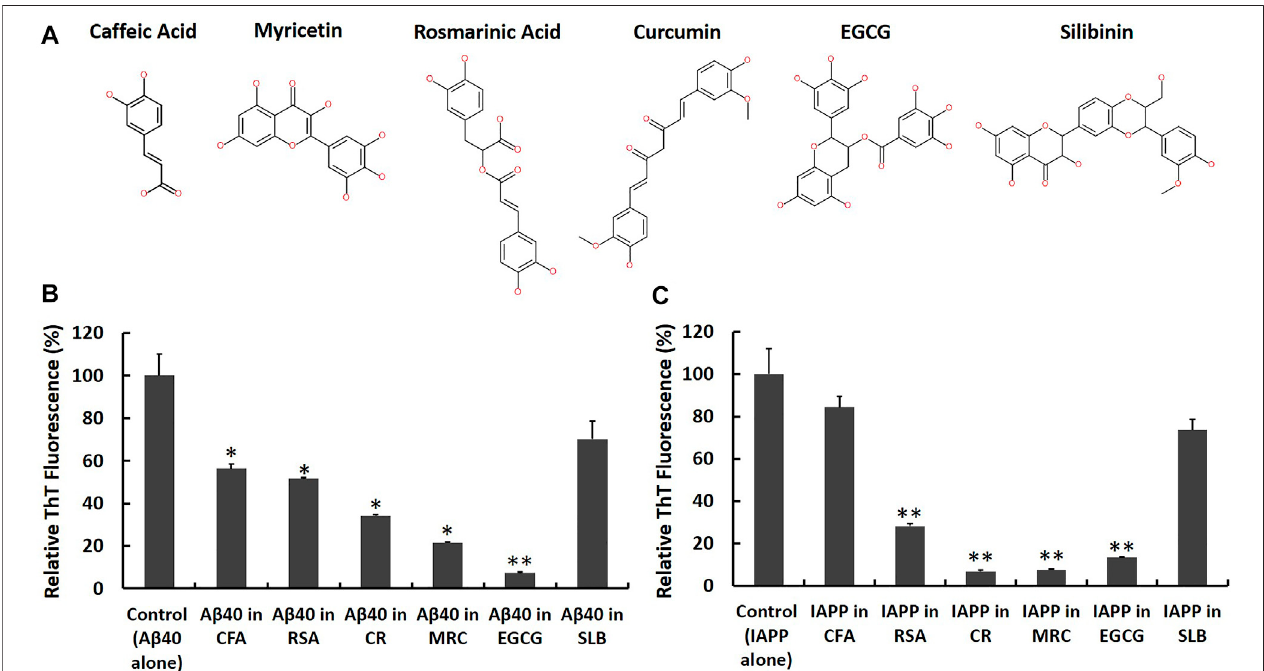
FIGURE 5 | Screening candidate polyphenolic inhibitors against A β 40 and IAPP self-aggregation using ThT fl uorescence assay. (A) 2D chemical structures of the candidate inhibitors including CFA: Caffeic acid, RSA: Rosmarinic acid, CR: Curcumin, MRC: Myricetin, EGCG: (-)-Epigallocatechin gallate and SLB: Silibinin. Samples containing (B) A β 40 monomers (40 μ M) and (C) IAPP monomers (40 µM) were prepared in absence and presence of an equimolar concentration of each candidate inhibitor and the ThT fl uorescence intensities of aged samples were obtained and normalized relative to control samples, ( fl uorescence of sample/ fl uorescence of A β 40 alone or IAPP alone) × 100. Data represent mean ± SE ( n = 3). * p -value < 0.01, ** p -value <